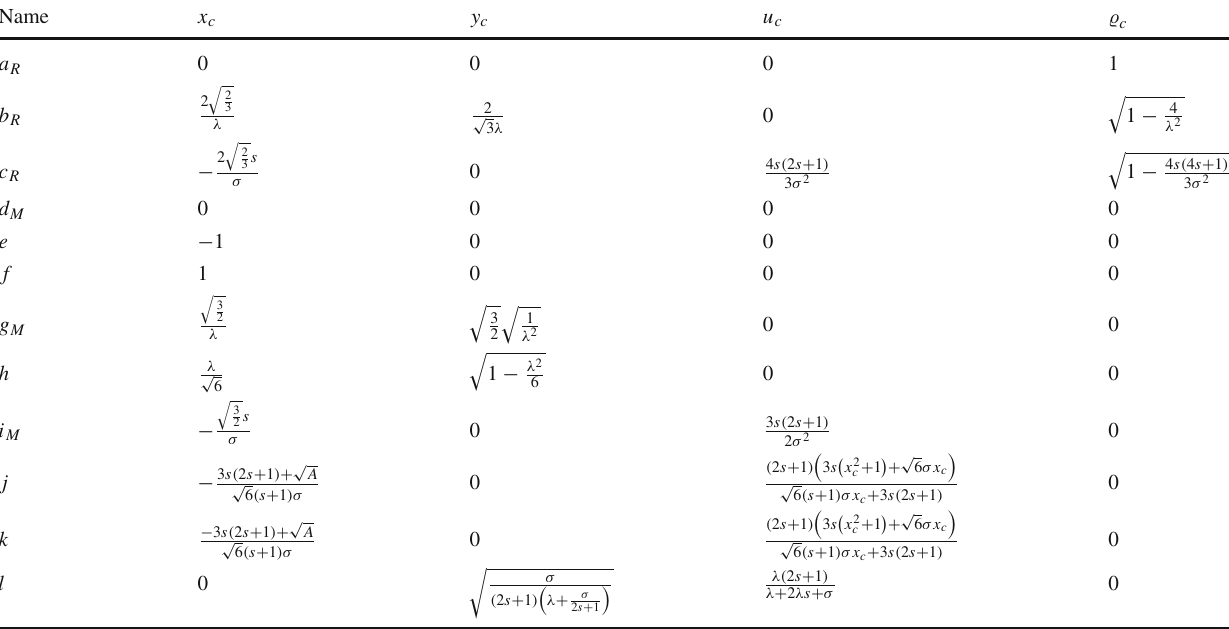
Table1 Criticalpointsfortheautonomoussystem (44)–(49)for V (φ) = V 0 e − λκφ and F (φ) = F 0 e − σκφ .Wedefine A = 9 s 2 ( 2 s + 1 ) 2 − 6 s ( s + 1 )σ 2